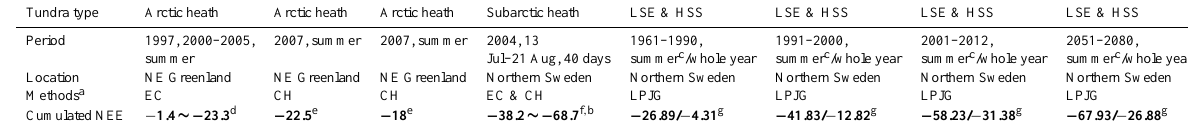
a EC stands for eddy covariance method, CH stands for chamber method and LPJG stands for model estimations with LPJG-WHyMe-TFM. b Values vary from sparsely vegetated areas (less than 10% cover) to fully covered low-growing Empetrum areas. c The modeled values in summer include data for June, July, August and September. LSE: low-growing (<50cm) evergreen shrubs. HSS: tall (<2m) deciduous shrubs. d Groendahl et al. (2007). e Tagesson et al. (2010). f Fox et al. (2008). g This